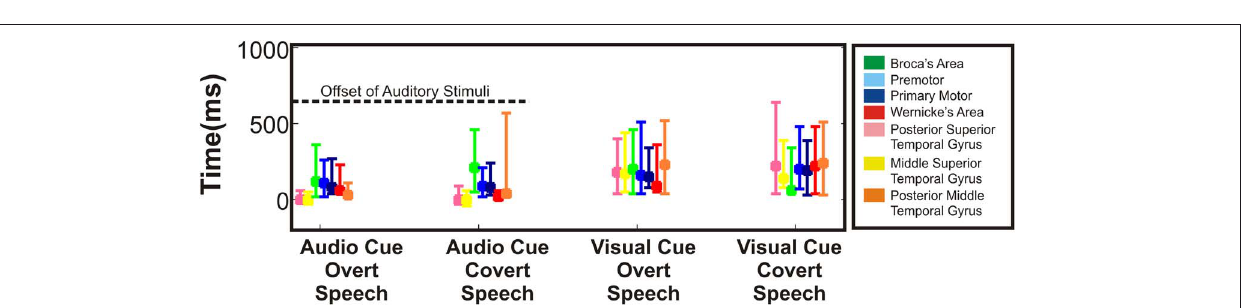
FIGURE 8 | Variability in onset of cortical activation. Timing of statistically significant cortical activations in terms of onset (earliest time at which site achieved significance) was averaged across all regions and across all patients. Height of the bar represents mean time of onset for the respective